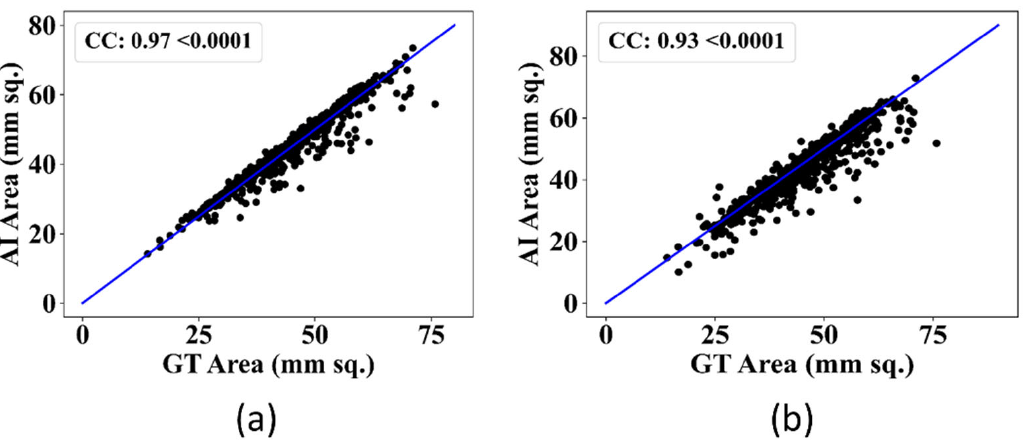
Figure 16. CC for GT and AI-estimated area for ( a ): UNet model, ( b ): UNet+ model.